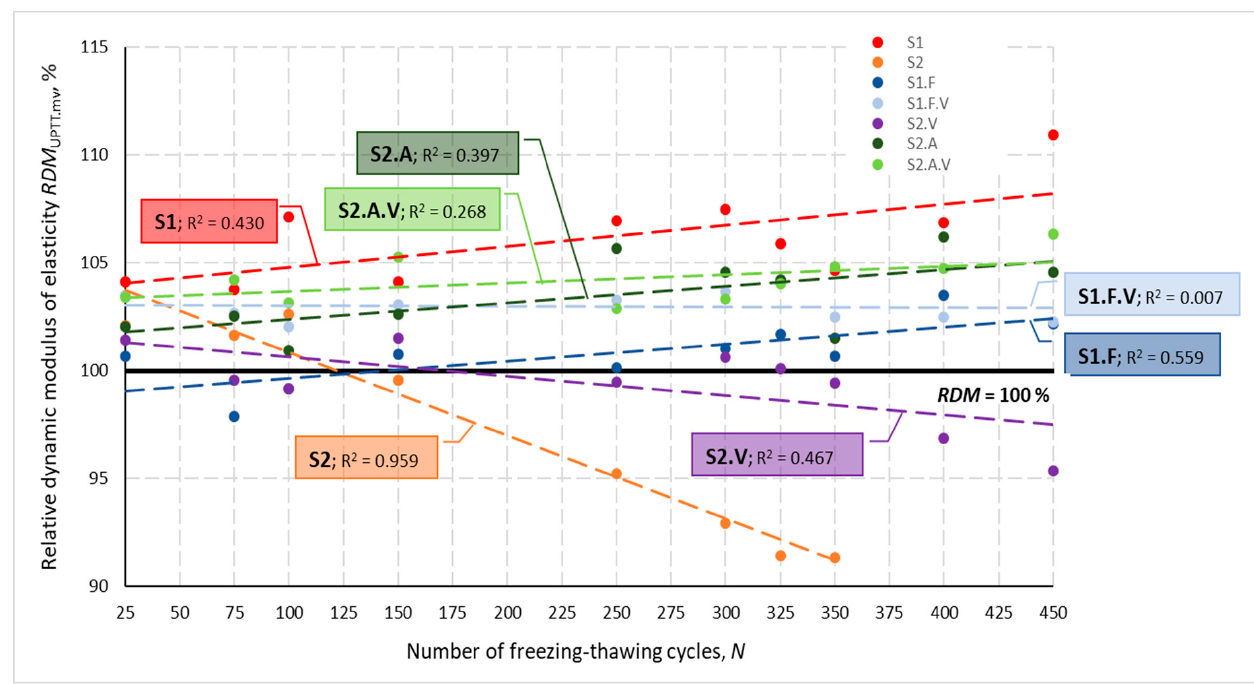
Figure 2. Mean relative dynamic modulus of elasticity for individual concretes after N cycles of freezing and thawing.